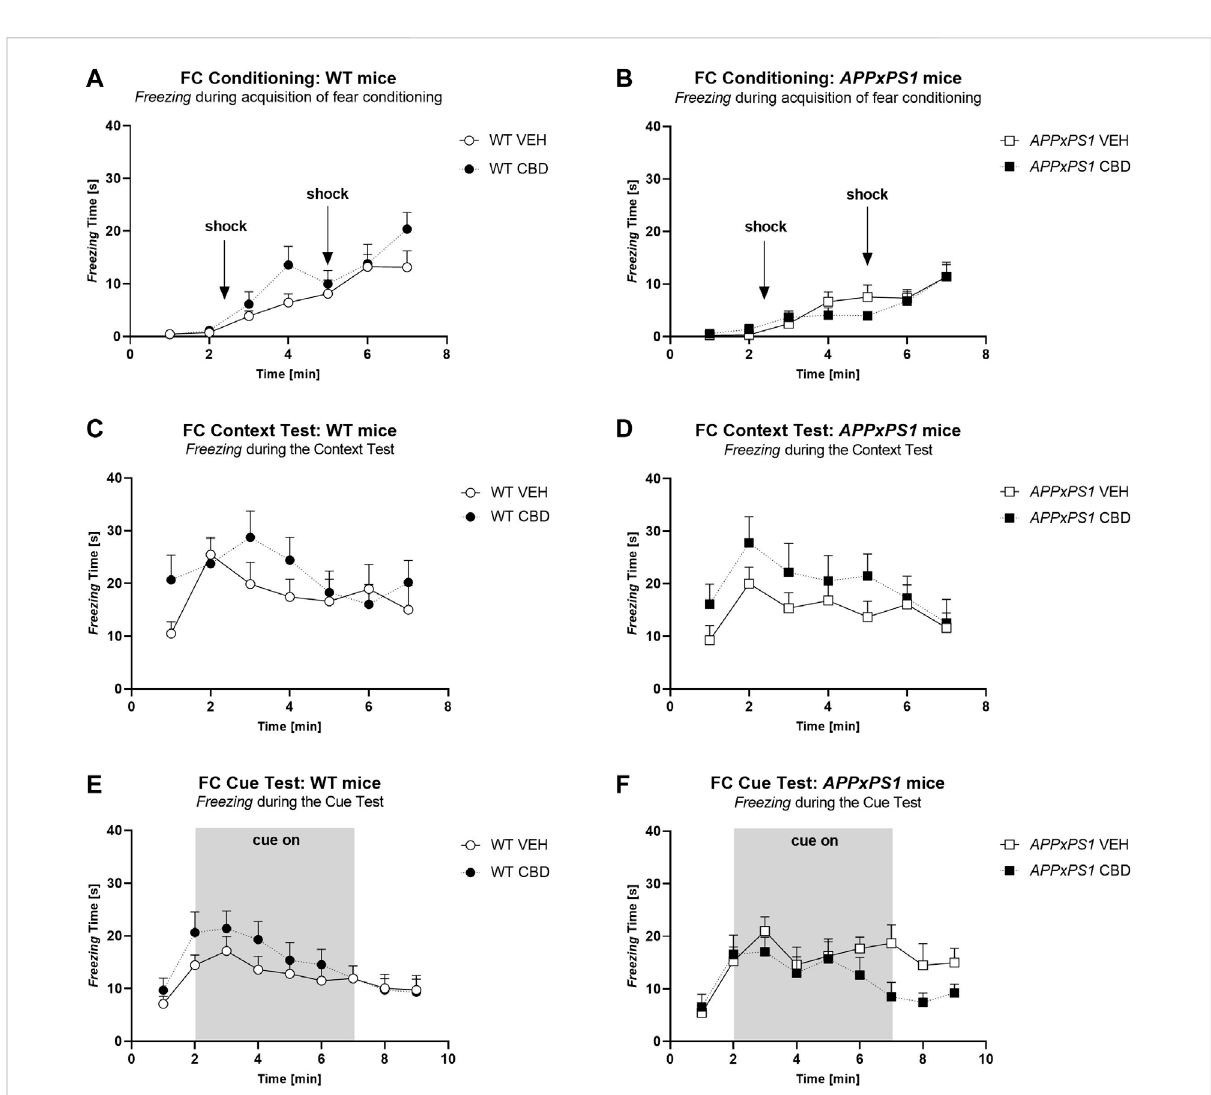
FIGURE 1 Freezing time [s]during (A,B) acquisition offear conditioning, (C,D) context test,and (E,F) cue testin APPxPS1 and WTfemalemice treateddaily with 20 mg/kg CBD or VEH for 8 months. Interactions were present in (A, B) between “ minutes ” × “ genotype ” ( p = 0.02) and in (E,F) between “ minutes ” × “ treatment ” ( p =0.02).Datawereanalysedusingthree-wayRMANOVAandpresentedasmean±SEMinseparategraphsforvisualclarity. N = 14 WT VEH, 16 APPxPS1 VEH, 14 WT CBD, and 13 APPxPS1 CBD. Abbreviations: APPxPS1 : amyloid precursor protein x presenilin 1 ; CBD: cannabidiol; VEH: vehicle; WT: